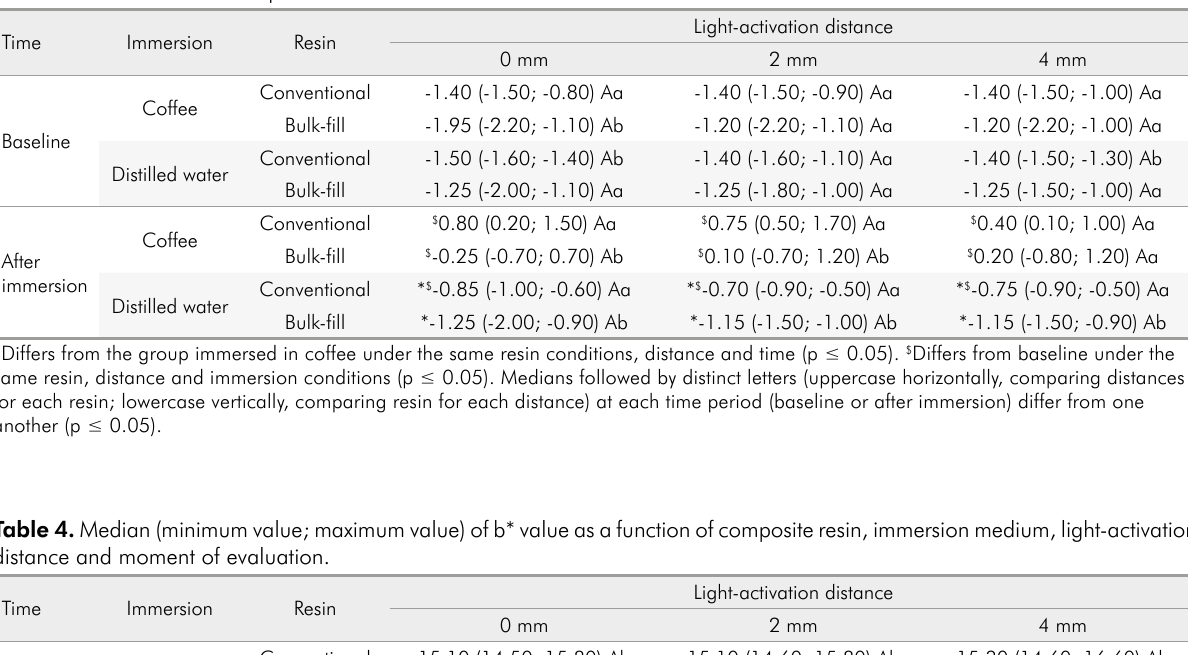
Table 3. Median (minimum value; maximum value) of a* value as a function of composite resin, immersion medium, light-activation distance and evaluation time periods.